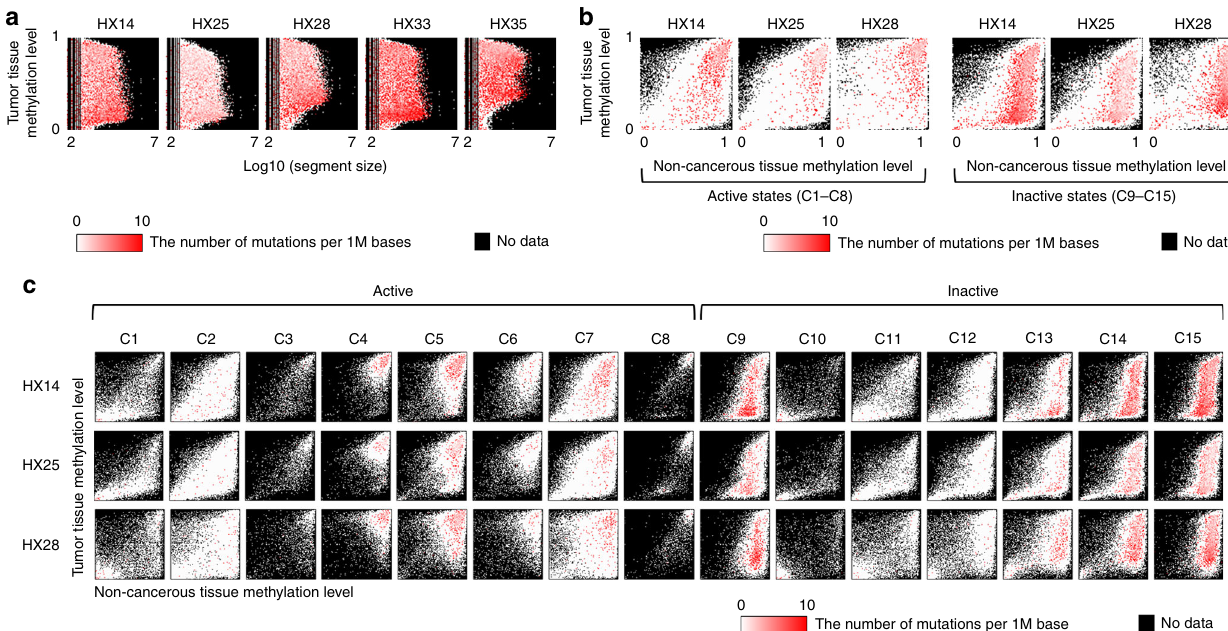
Fig. 2 Density of mutations in the different epigenetic states in hepatocellular carcinoma. a The distribution difference of somatic mutations that depending on the differences in size ( x -axis) and tumor methylation level ( y -axis) of the region delimited by 15 epigenomic segments. Red indicates the number of mutations per million bases calculated for each fraction of the images in Supplementary Fig. 5a, which were divided into 100 × 100 areas. b Comparison of the distribution of somatic mutations between the active or inactive chromatin status. The x -axis indicates the methylation level of the non-cancerous liver genome and the y -axis indicates that of the tumor. The accumulation of mutations was higher in hypo-methylated regions in the inactive chromatin. Red indicates the number of mutations per million bases calculated for each fraction of the images of the lower panel of Fig. 1a, which were divided into 100 × 100 areas. c Density of mutations in the 15 epigenomic segments. Red indicates the number of mutations per million bases calculated for each fraction of the images of Fig. 1b, which were divided into 100 × 100